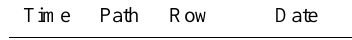
Table 1. Landsat image description. Time